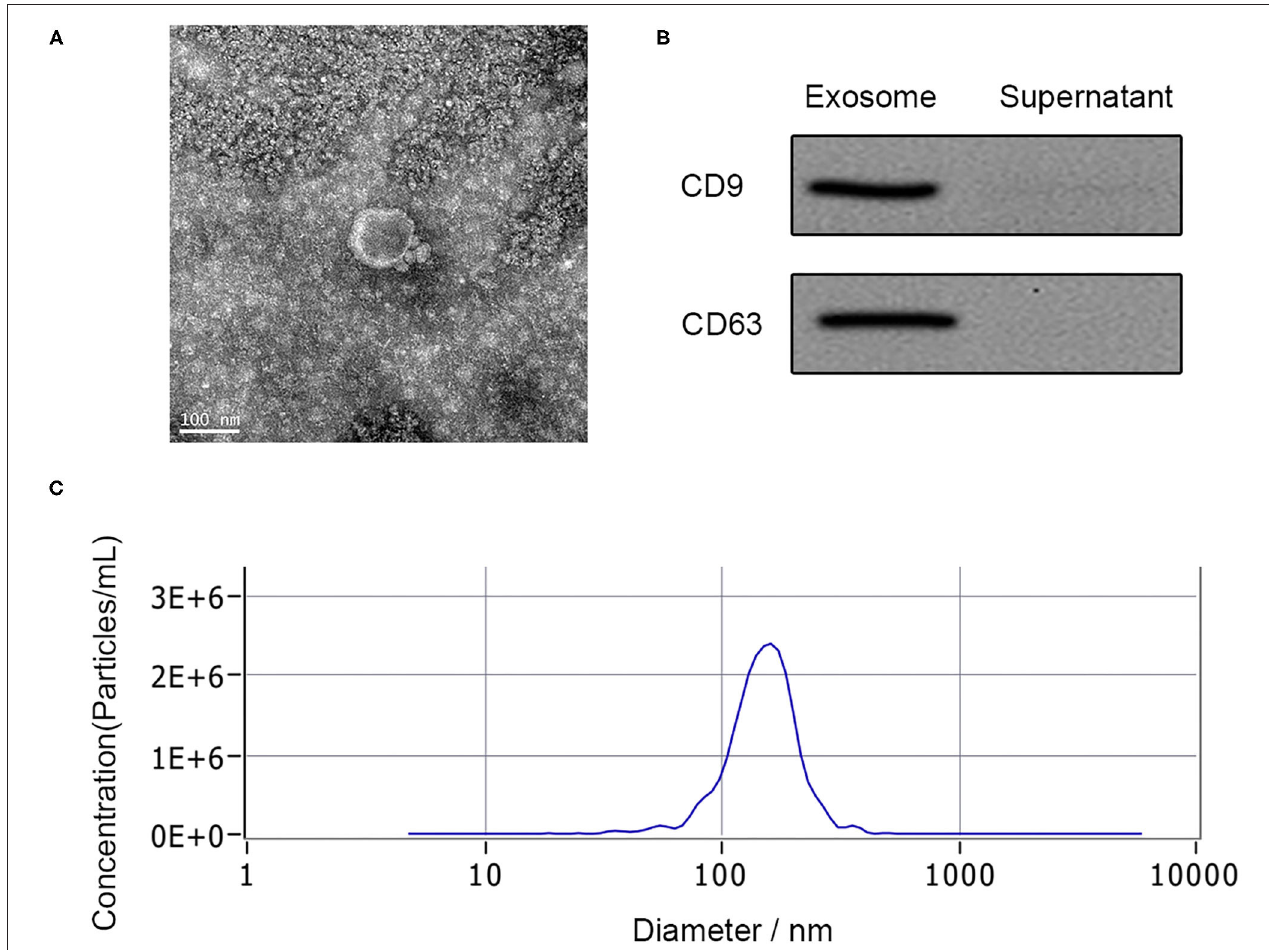
FIGURE 1 | Characterization of human plasma delivered exosomes. (A) The morphology of exosomes by TEM. (B) The specific exosomes surface markers (CD9 and CD63) by western blotting. (C) Nanoparticle tracking analysis of